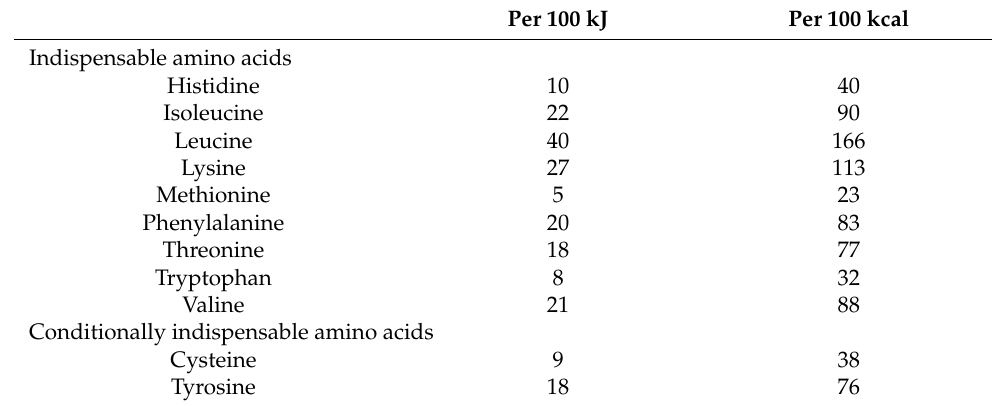
Table 3. Indispensable and conditionally indispensable amino acids in breast milk (mg)